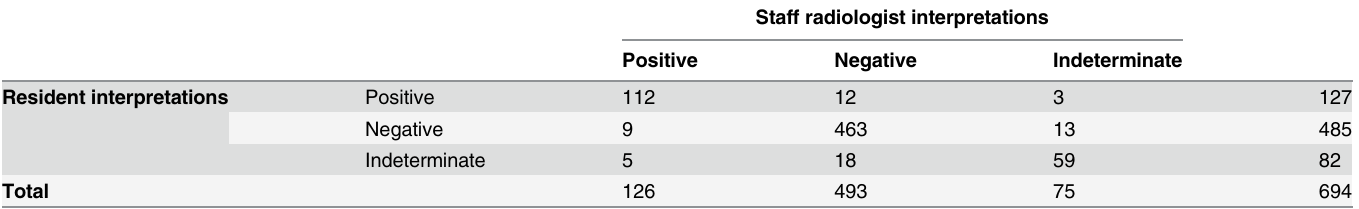
Table 1. Staff radiologists and residents interpretations of CT Pulmonary Angiograms regarding the pretsence of a pulmonary